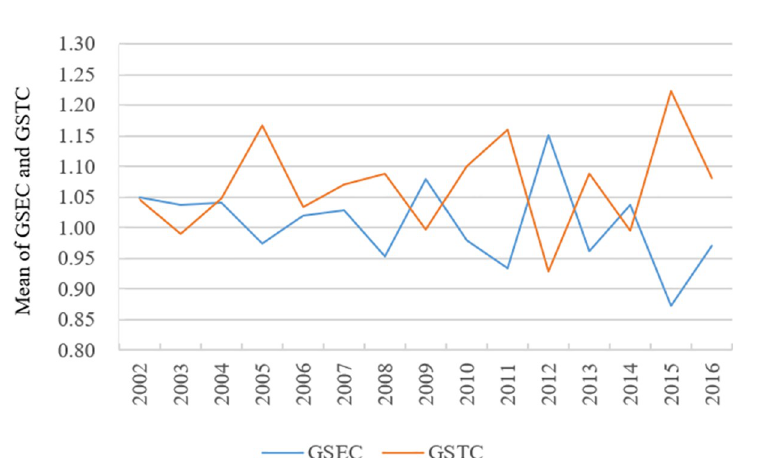
Fig 7. Changes in GSEC and GSTC of tourism development in China’s major cities in 2002–2016.